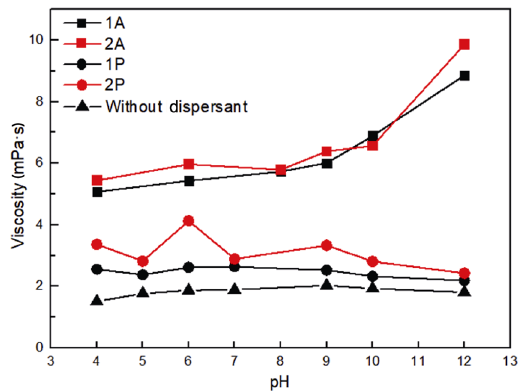
Fig. 3 Dependence of viscosity on the pH value for the Ti 3 AlC 2 suspensions with Arabic gum and PAA dispersants. dispersant, the pH has little effect on the viscosity. The viscosity stabilizes around 1.5 mPa·s. For PAA, the pH has little effect on the viscosity. The dispersant amount shows slightly influence on the viscosity. For arabic gum, the viscosity increases from 5 to 7 mPa·s as pH changes from 4 to 10, while rises to 9 mPa·s at pH of 12. Omura et al. [26] have found that the Al suspensions with a viscosity of 6 mPa·s is available for slip casting. In the aspect of viscosity results, arabic gum at pH around 10 could be the best choice for the